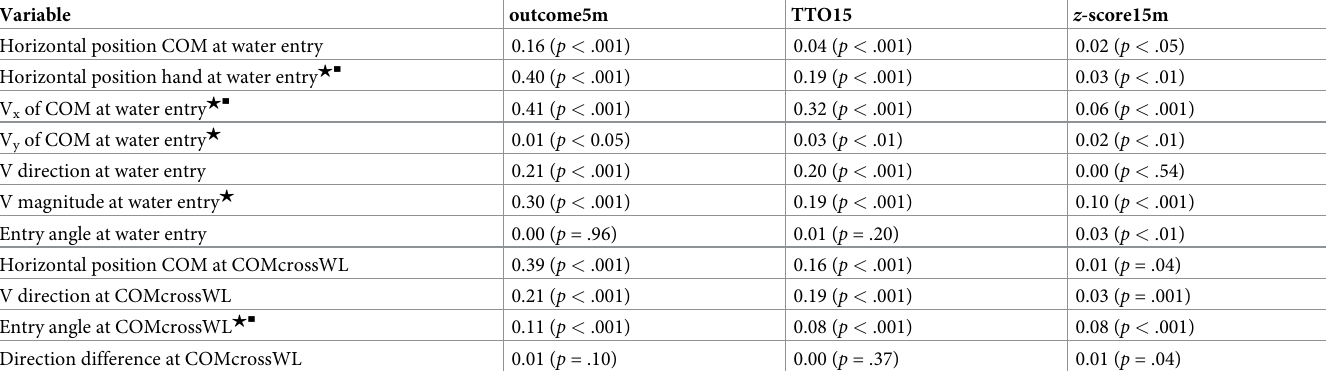
Table 6. Results of the simple linear regression analysis (initially selected $ , included in the final model ■ ). Results are presented as r 2